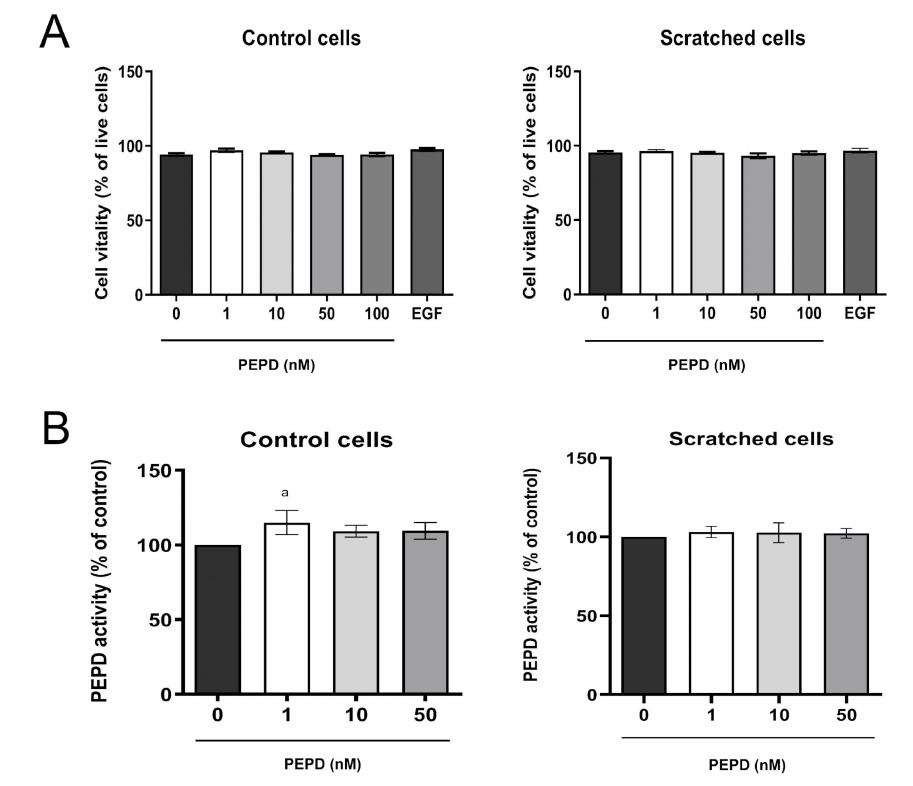
Figure 2. Prolidase does not a ff ect the vitality and prolidase activity of keratinocytes. ( A ) Cell vitality and ( B ) PEPD activity in control and scratched HaCaT cells, treated with di ff erent concentrations of prolidase (1–100 nM) and EGF (10 nM) for 24 h. A mean ± SEM of three replicates is presented. The results are significant at a < 0.05. Statistically significant di ff erences were calculated vs. control (0 nM of